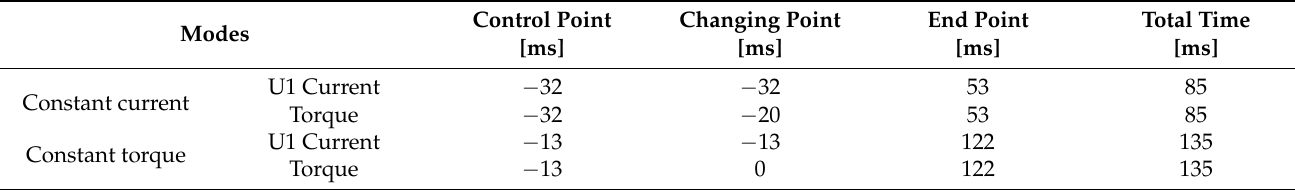
Table 13. Comparison of detailed transient-state time.